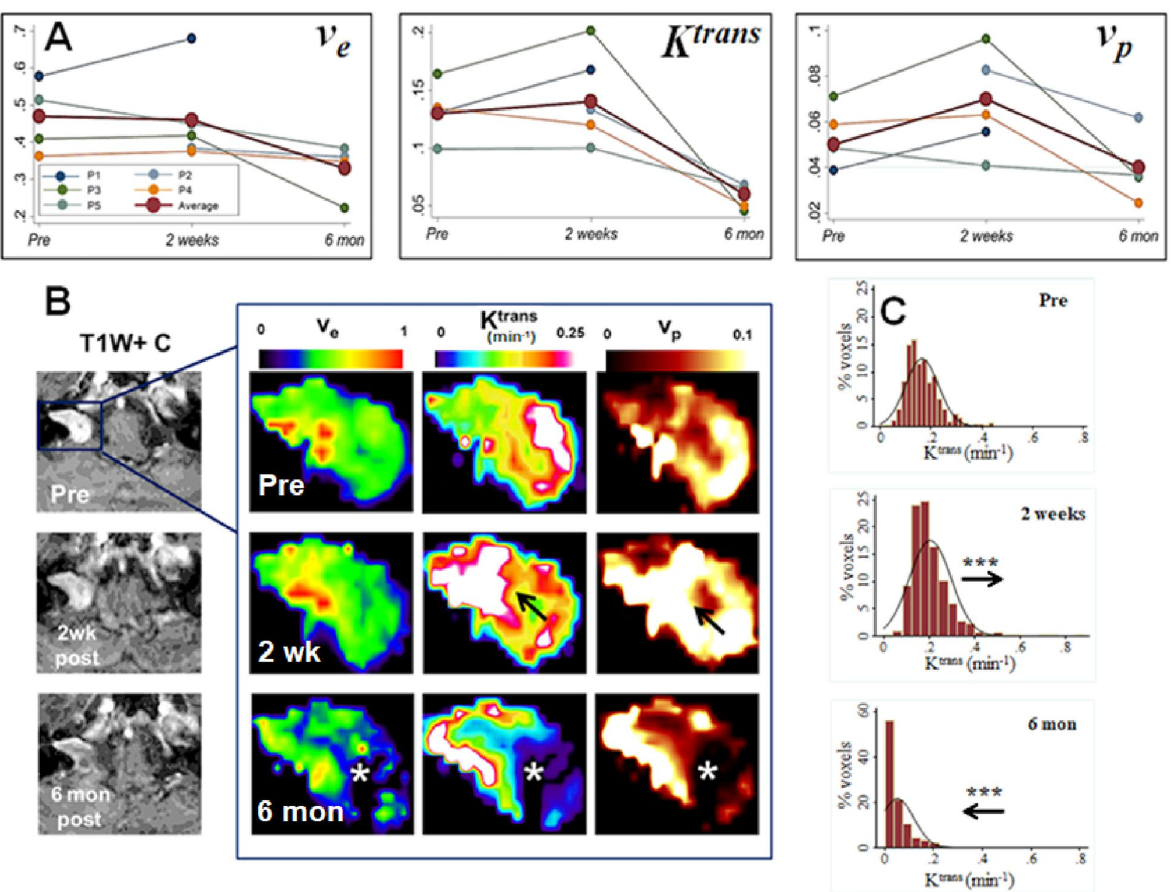
Figure 2. Post-SRS changes in tumour microvascular parameters. ( A ) Line-graphs demonstrating temporal trend in mean tumour v e (no units), K trans (min −1 ) and v p (no units) for five VS. Average trend (red line) across all tumours also shown. ( B ) Representative parameter maps from the right-sided growing VS shown in Panel A (patient 3, P3). From left to right: T1W post-contrast, co-registered voxelwise maps of v e , K trans , and tumour v p . Note the early increase in tumour K trans and v p at 2 weeks post-treatment ( arrow ) followed by marked reductions in v e , K trans , and v p within the cerebellopontine angle portion of the tumour at 6 months post-SRS (*). ( C ) Histogram of voxelwise K trans values within the tumour pre-treatment (top), 2 weeks post-treatment (middle) and 6 months post-treatment (bottom). *** p < 0.001 for comparison with pre-treatment TSC values, repeated- measures ANOVA with post hoc (Bonferroni) analysis of pairwise comparison. Arrows show movement in histogram relative to preceding imaging